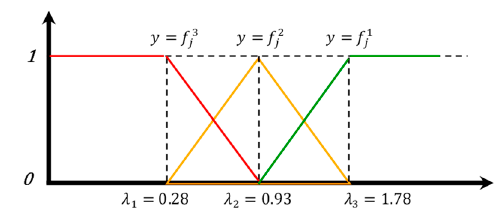
Figure 3. Representation of the whitenization functions for criterion 1 (C1).